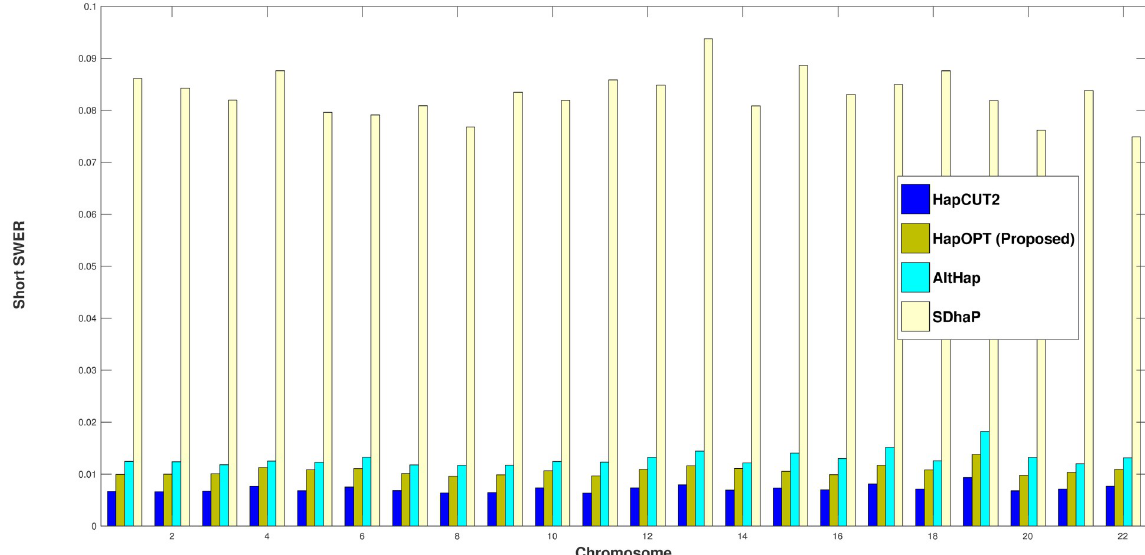
Fig 3. Short SWER of HapOPT, HapCUT2, AltHap, and SDhaP on real fosmid data.